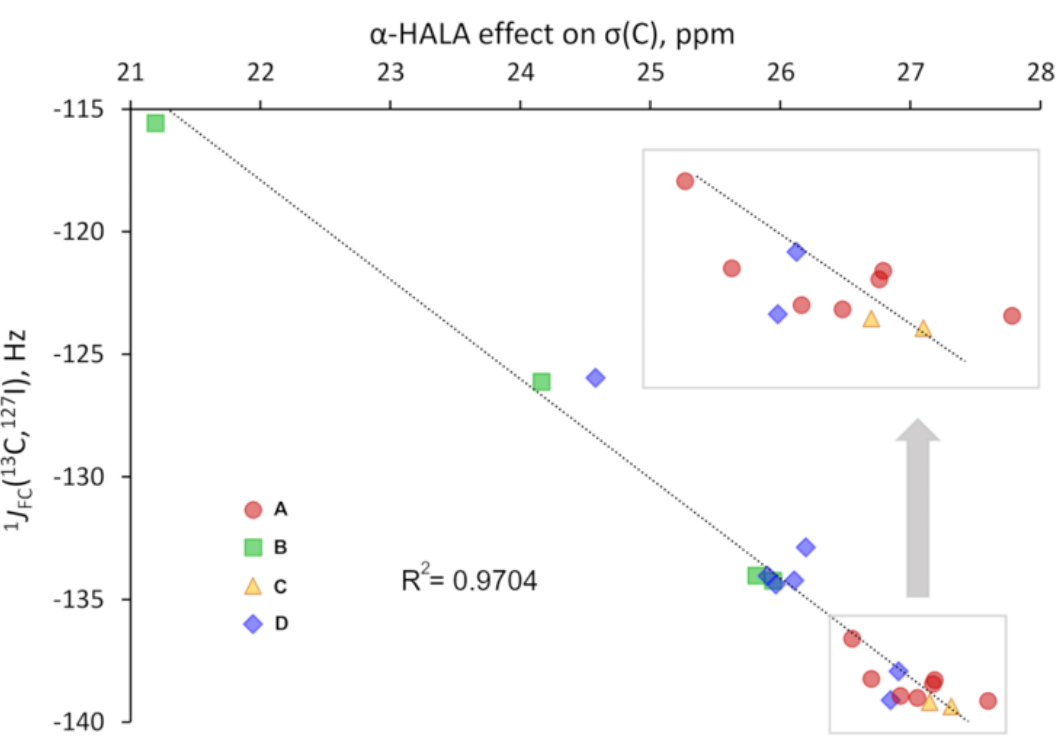
Figure 10. The correlation plot for the α -HALA effect from the iodine atom on the σ( 1 H) and the corresponding 1 J FC ( 1 H, 127 I) in HI upon varying the basis set on the light hydrogen atom.